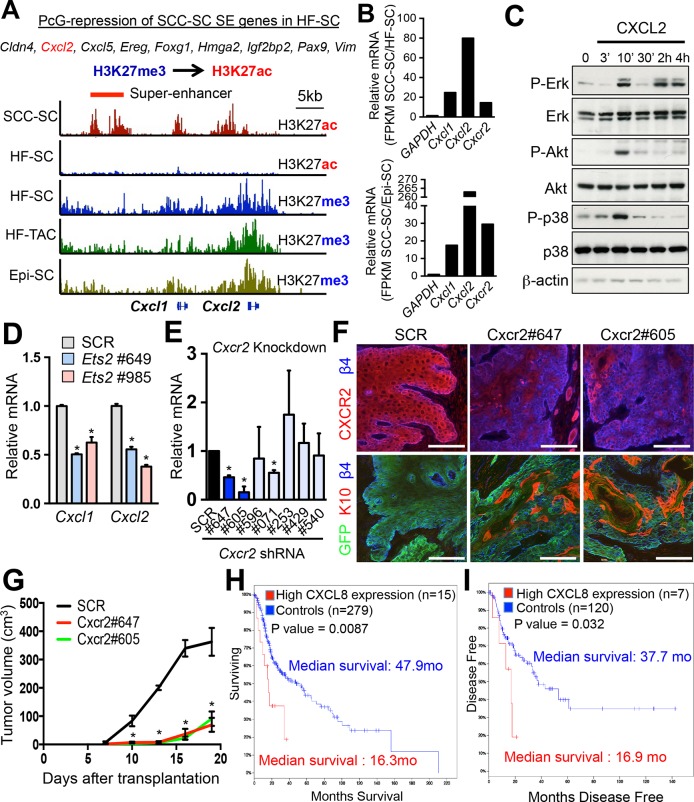
Inflammatory mediators are SCC-SE-regulated and affect SCC growth.(A) Chromatin status at the Cxcl1/2 locus in SCC-SCs versus normal skin progenitors. Note that strong peaks of H3K27ac-associated, active chromatin are present throughout this locus in SCC-SCs, while in normal skin progenitors, the locus is heavily marked by H3K27me3, indicative of Polycomb-mediated repression. (B) Gene expression changes of Cxcl1, Cxcl2, and Cxcr2 (encoding the receptor for CXCL1/2) in SCC-SCs compared to their normal HF-SC or Epi-SC counterparts. (C) Immunoblot analysis shows that CXCL2 activates MAPK signaling in HRasG12V; Tgfbr2-null keratinocytes. β-actin levels are shown as controls. (D) Knock-down of Ets2 reduces Cxcl1/2 mRNA expression. (E) Knock-down efficiency of Cxcr2 shRNAs in HRasG12V; Tgbr2-null cells as measured by quantitative RT-PCR. (n = 3 ± SEM *p<0.05). (F) Immunofluorescence images of allograft tumors (GFP) from Cxcr2-shRNA and scrambled control-shRNA transduced SCC-SC cells. Note that CXCR2-reduction is accompanied by a marked increase in K10+ differentiated cells within the tumors. Scale bars, 100 μm. (G) Changes in tumor volume of Cxcr2 knock-down and control allografts over time (n = 3). (H and I) High CXCL8 expression (the closest human homologue for CXCL1/2) correlates with shortened survival in human head & neck SCC patients. Kaplan–Meier analysis comparing overall survival (H) and disease-free survival (I) of TCGA HNSCC patients stratified according to the highest (>5th percentile) CXCL8 expression/amplification versus the rest (>5th percentile) (please visit http://bit.ly/1Afq0Gt). SC, stem cell; SCC, squamous call carcinoma.